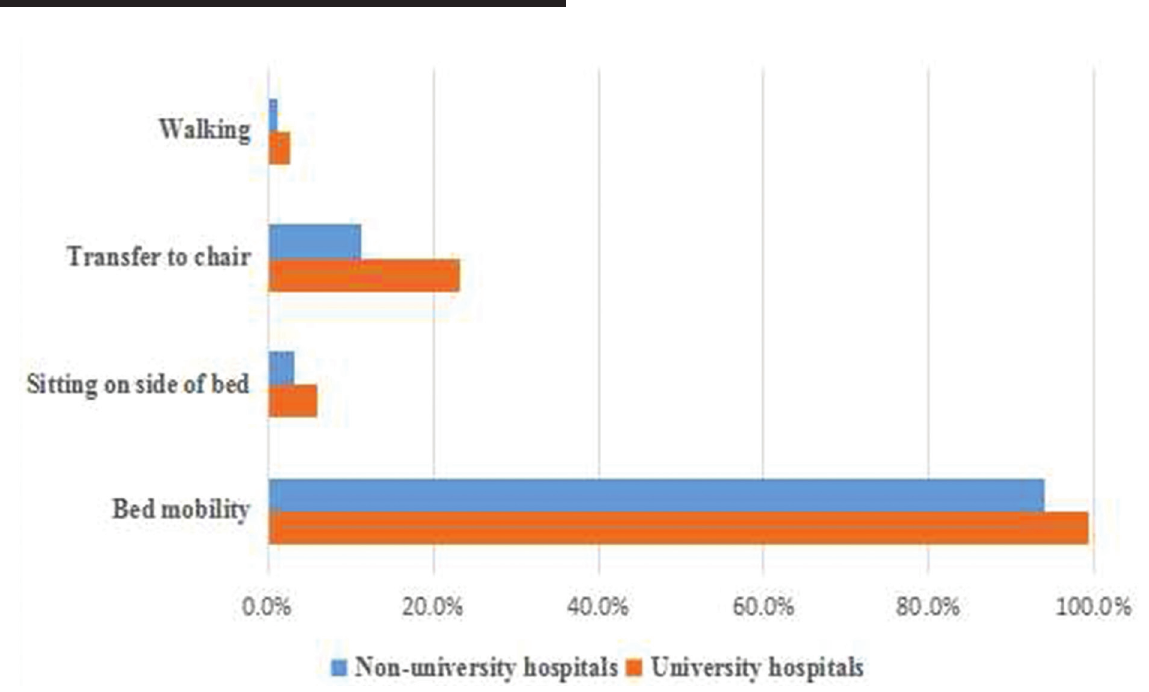
Figure 1. EM level compared in university and non-university hospitals ( n =1,353). Abbreviation: EM, early mobility.